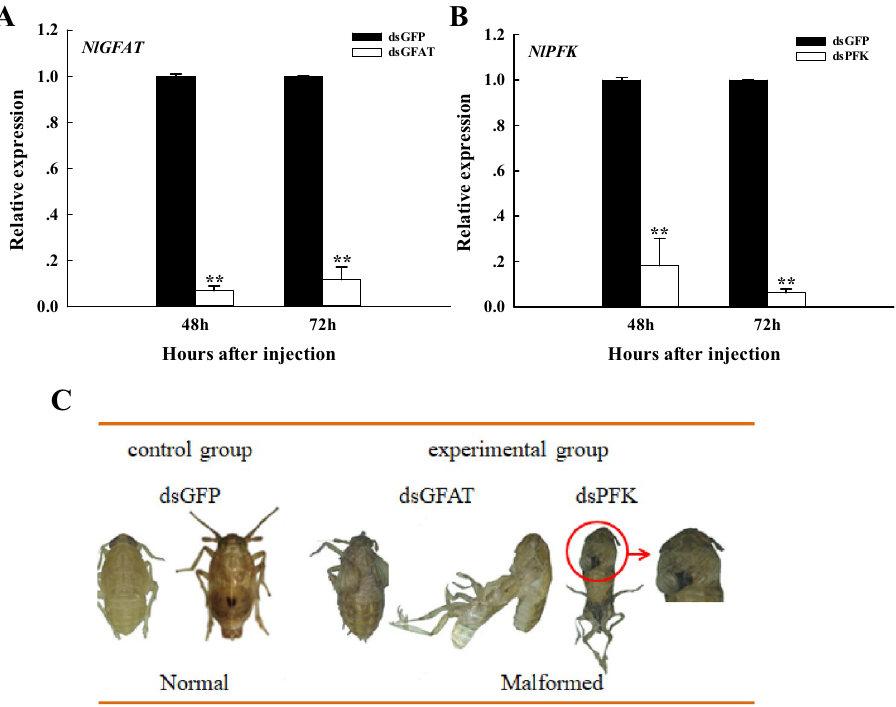
Figure 3. Relative expression levels of GFAT ( A ) and PFK ( B ) after dsGFAT and dsPFK injection, and phenotype changes ( C ) after dsRNA injection in Nilaparvata lugens . GFAT, glutamine:fructose-6-phosphate aminotransferase; PFK, phosphofructokinase. The N. lugens used for the microinjection of RNAi were at the 1st day of 5th instar nymph stage. dsGFAT or dsPFK injection were used as the test groups whereas dsGFP injection was used as the control group. Gene expression levels were measured by quantitative real-time PCR with 18S RNA as the internal control. Values are means ± SE from three independent measurements. Different letters indicate significant differences according to Duncan’s test ( p < 0.05).